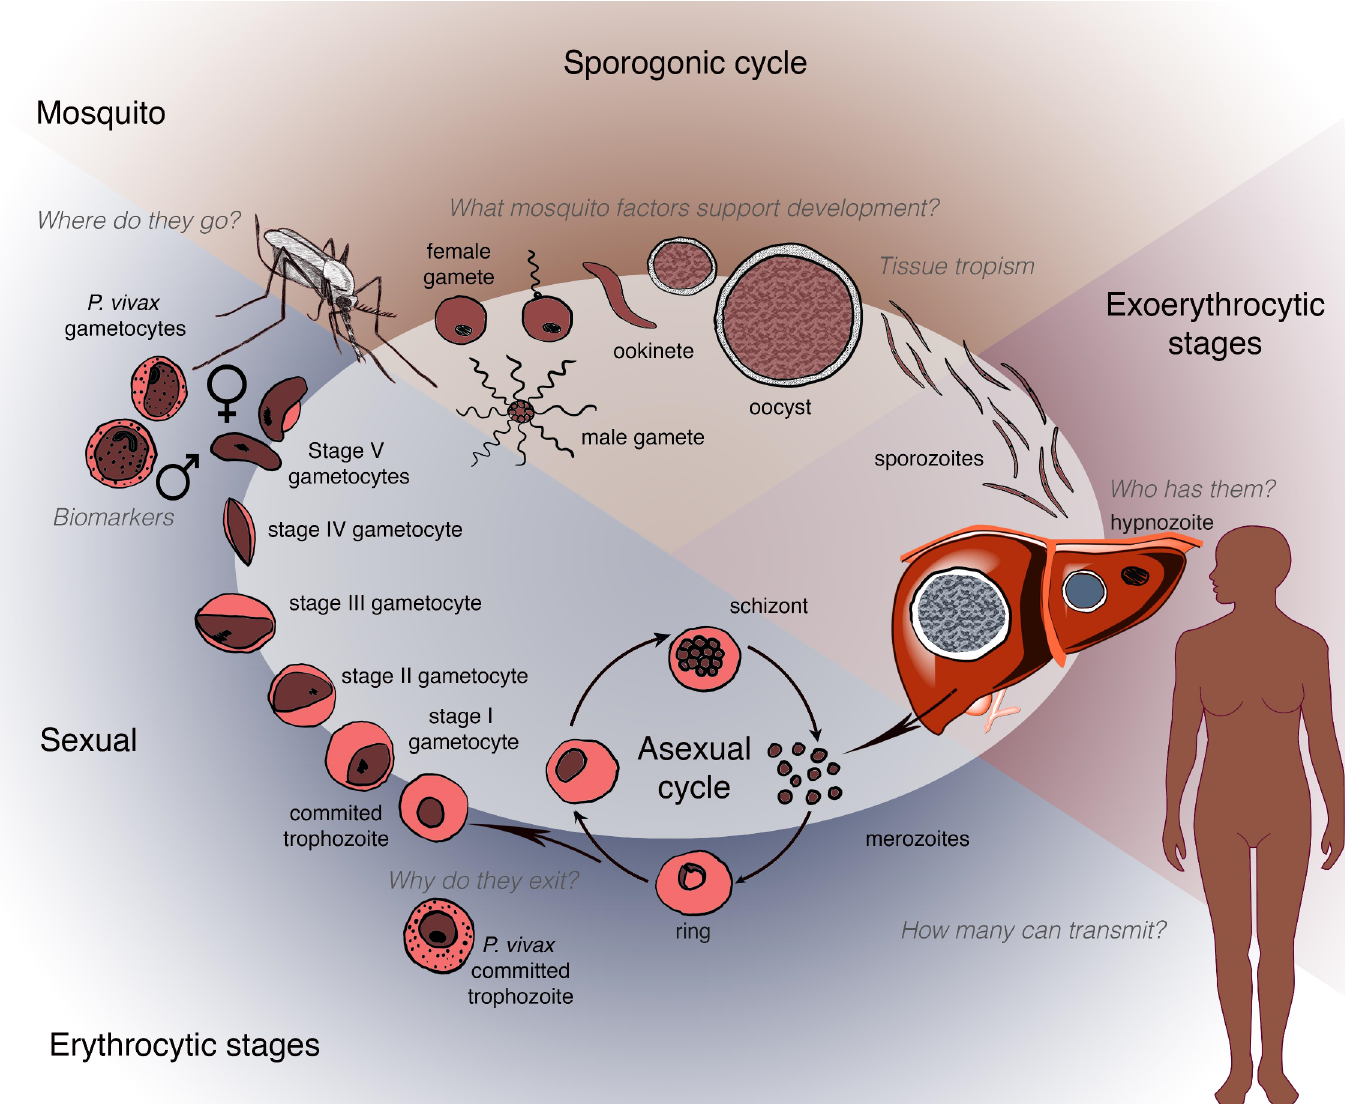
Fig 1. Schematic depicting the human and mosquito life cyclesof Plasmodium , highlighting critical questions at specific points within the life cycle.